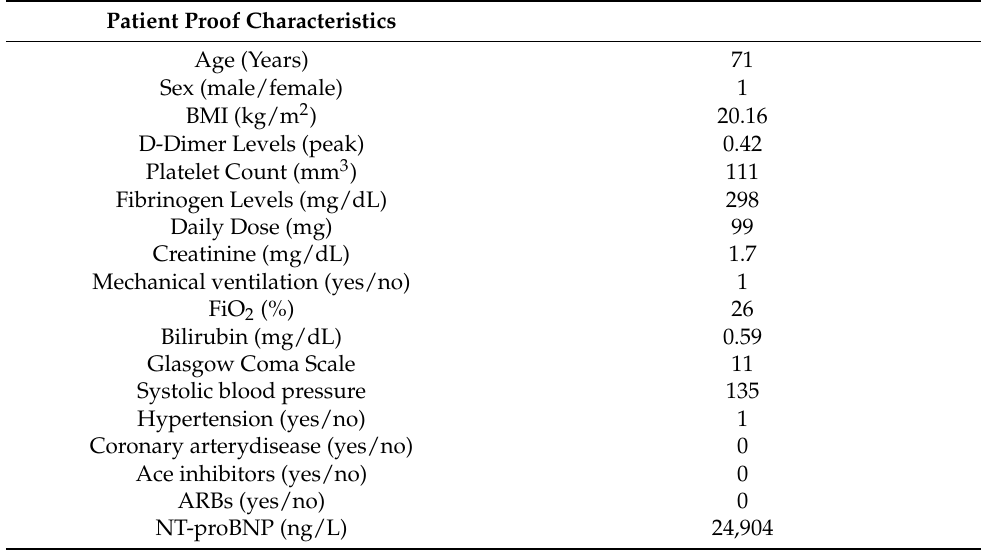
Table 6. Characteristics of the patient-proof. BMI = Body Mass Index; FiO 2 = fraction of inspired oxygen; GCS = Glasgow Coma Scale; ARBS= Angiotensin Receptor